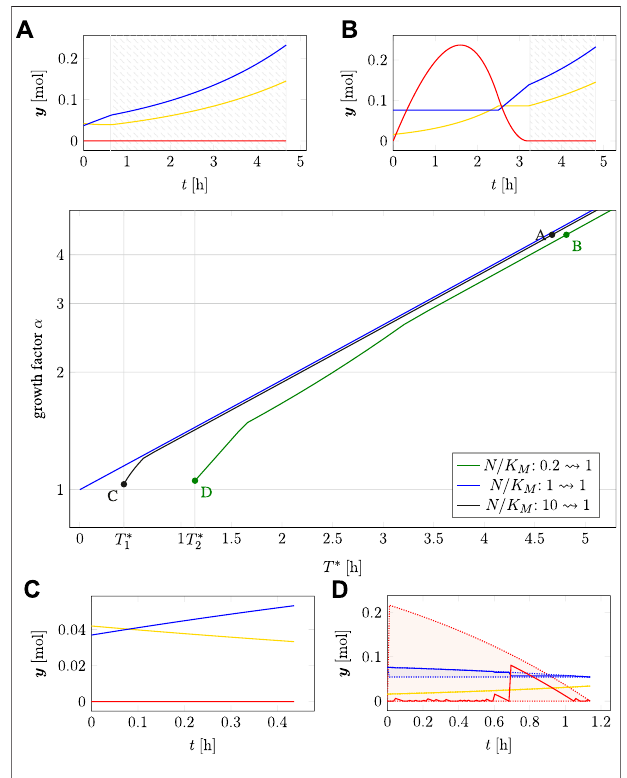
FIGURE 8 | Two-objective optimization of adaption time T * and total biomass growth factor α for time-optimal adaptation at a nutrient shift. Main plot: Pareto fronts for three different initial adaptations (measured in N/K M ) of 0.2, 1.0 and 10. Subplots (A – D) : Time courses at different points on the Paretofronts,cf. Figure7 .TheshadedareasinsubplotsAandBindicatetime intervals where the cell is perfectly adapted (exponential growth).